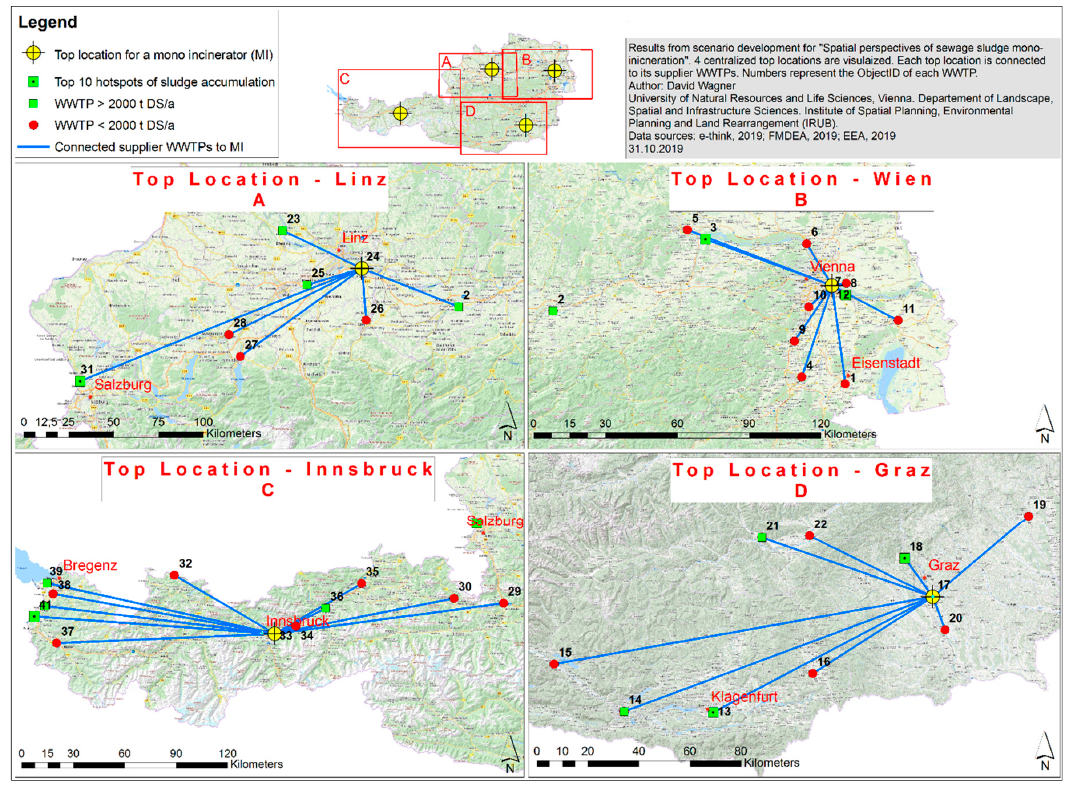
Figure 9. Resulting mono-incineration clusters for the centralized solution; Scenario 2(a,b).